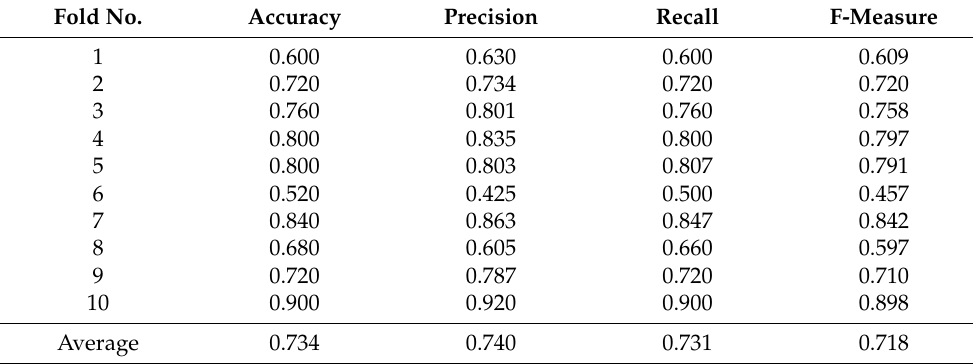
Table 10. Accuracy, precision, recall, and F-measure of Xception model (mixed-gender). Fold No.